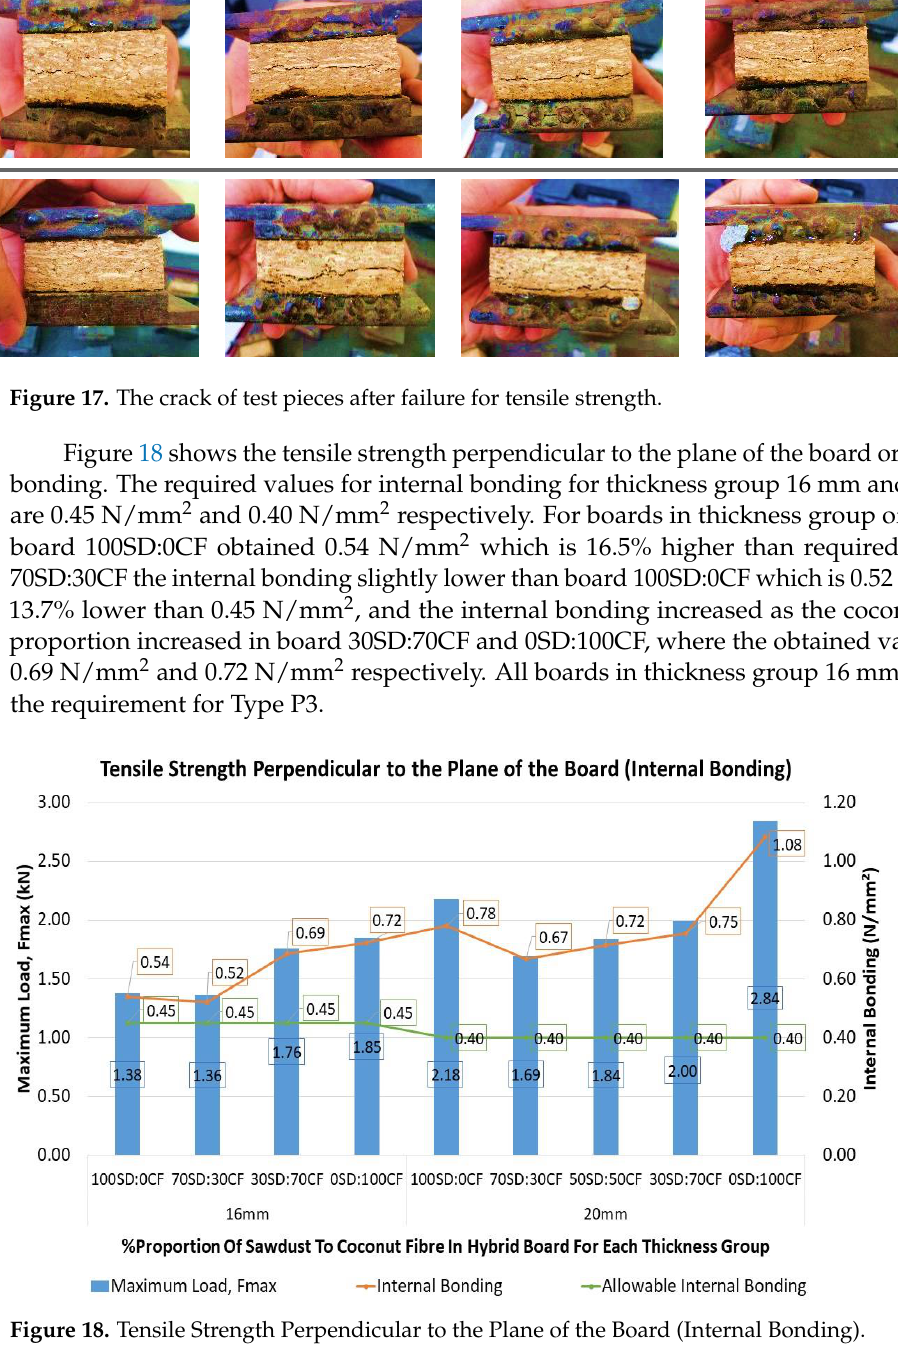
Figure 18. Tensile Strength Perpendicular to the Plane of the Board (Internal Bonding) .